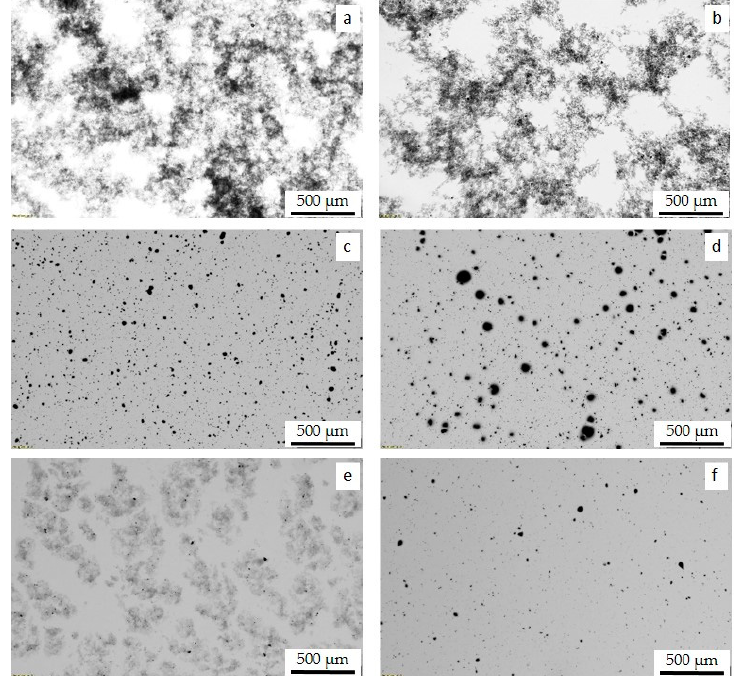
Figure 2. TLM images of PS and PB homopolymers with 1 wt % of MWCNTs dispersed in toluene